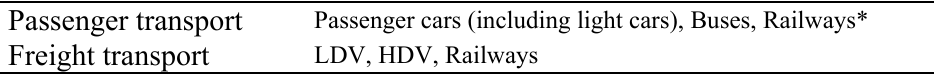
Table 11. Categories of transport modes in the Case Study for Aichi Prefecture Passenger